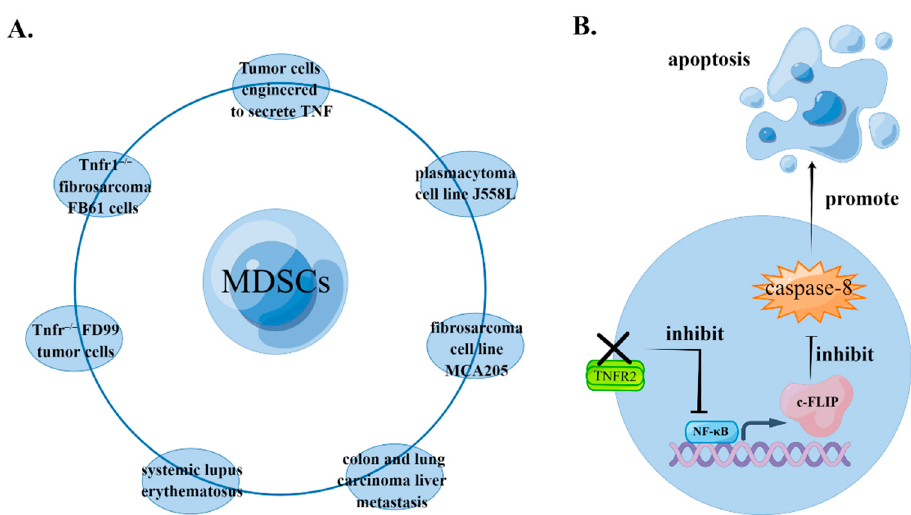
Figure 2. TNF signaling inhibits the apoptosis of MDSCs. ( A ) In systemic lupus erythematosus, colon and lung carcinoma liver metastasis models, transplanted tumor models with Tnfr − / − FD99 tumor cells, Tnfr − / − fibrosarcoma FB61 cells, tumor cells engineered to secrete TNF, plasmacytoma cell line J558L and fibrosarcoma cell line MCA205, TNF signaling inhibits the apoptosis of MDSCs. ( B ) In TNFR2-deleted MDSCs, NF- κ B signaling and its downstream molecule c-FLIP are downreg-